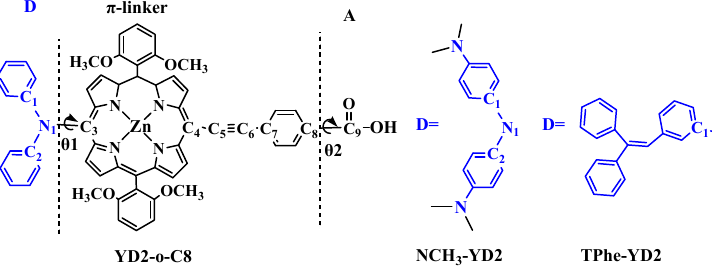
Figure 1. Schematic structure and the optimized geometry of YD2-o-C8, NCH 3 -YD2, and TPhe-YD2, together with the labeling scheme. The D, π -linker, and A indicates donor, π , and acceptor parts, respectively.